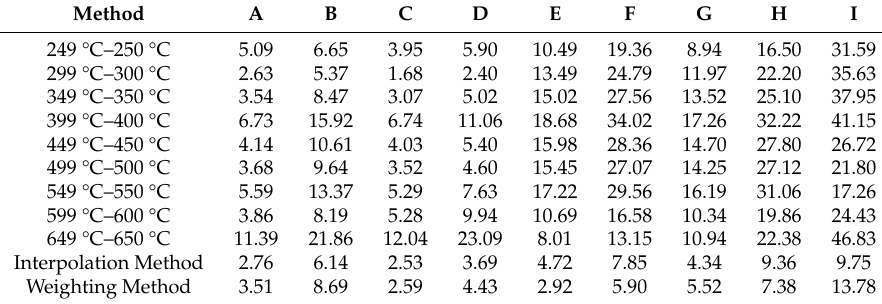
Table 7. A summary of peak differences between true (FEA) and predicted stress values ( ∆ σ VM ) for the test temperatures profiles, fitted using the three Green’s function implementation